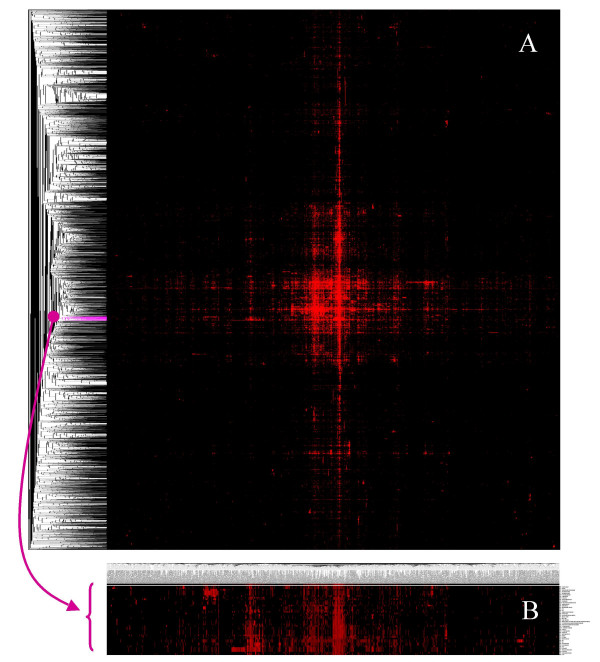
Hierarchical clustering of literature co-occurrences of 5626 genes (rows) versus 1275 diseases (columns). A co-occurrence was only taken into account when at least two articles mention the gene-disease pair. Each gene had to have at least once a high (1–100 scaled) relevance score of >46. A: Overview of all 5626 genes and 1275 diseases. B: Enlargement of a small subsection of genes showing the amount of detail present in the CoPub Mapper analysis.